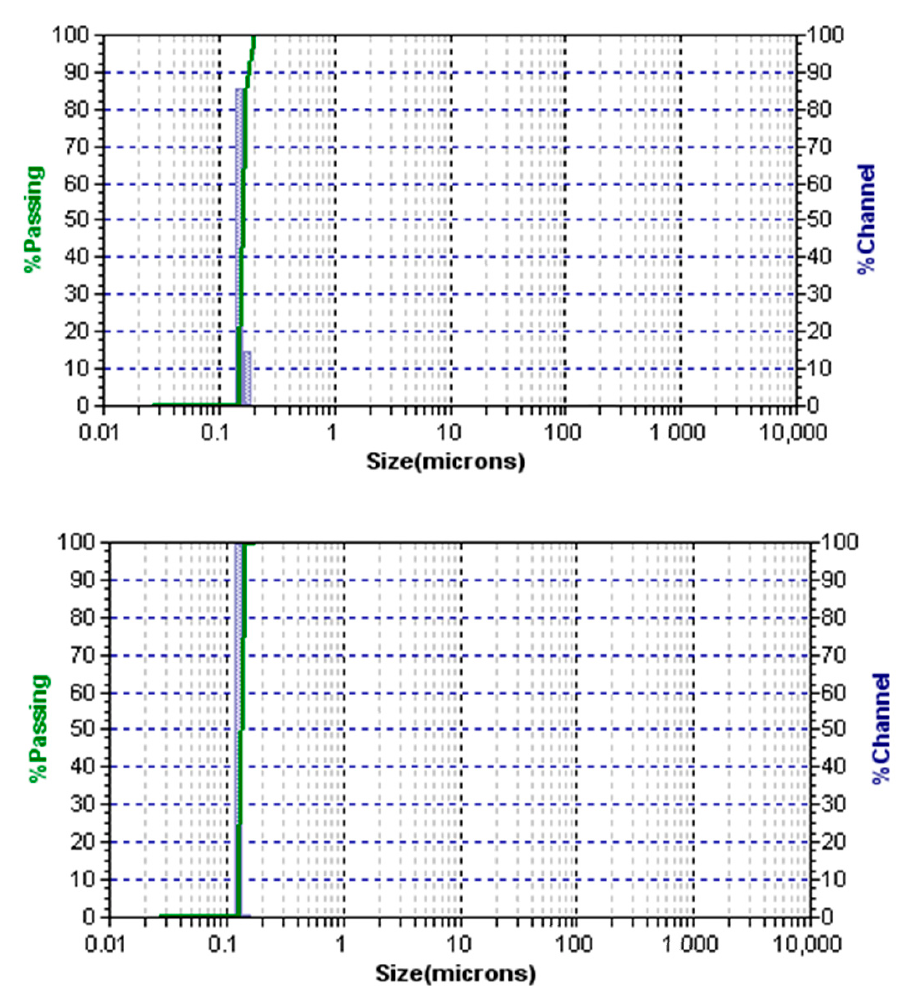
Figure 6. Laser di ff raction (LD): image of the final polymer product of the E2 run ( Top ) and the final polymer product of the E4 run ( Bottom ). Both images for samples collected after 5 h of polymerization initiation.